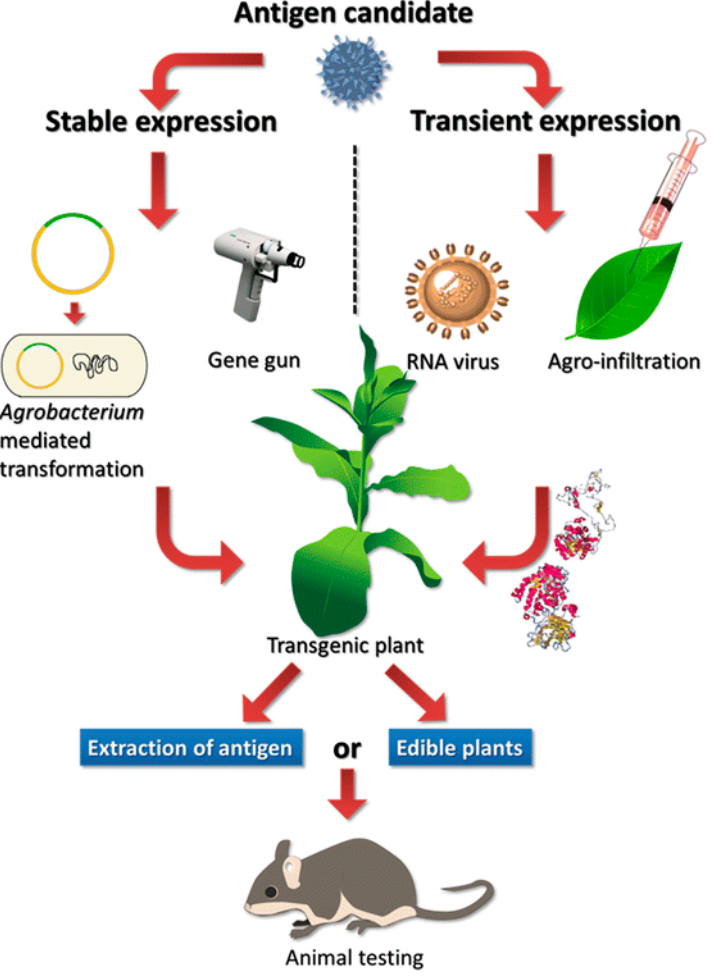
Figure 3. Schematic diagram of plant pharming.